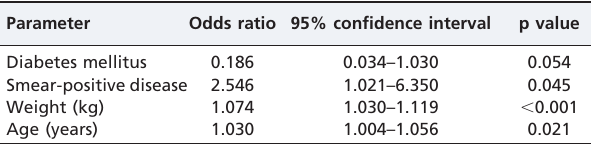
Table 4 - Predictors of obstructive defect (FEV 1 /FVC , 70%) within 60 months after completion of treatment for pulmonary